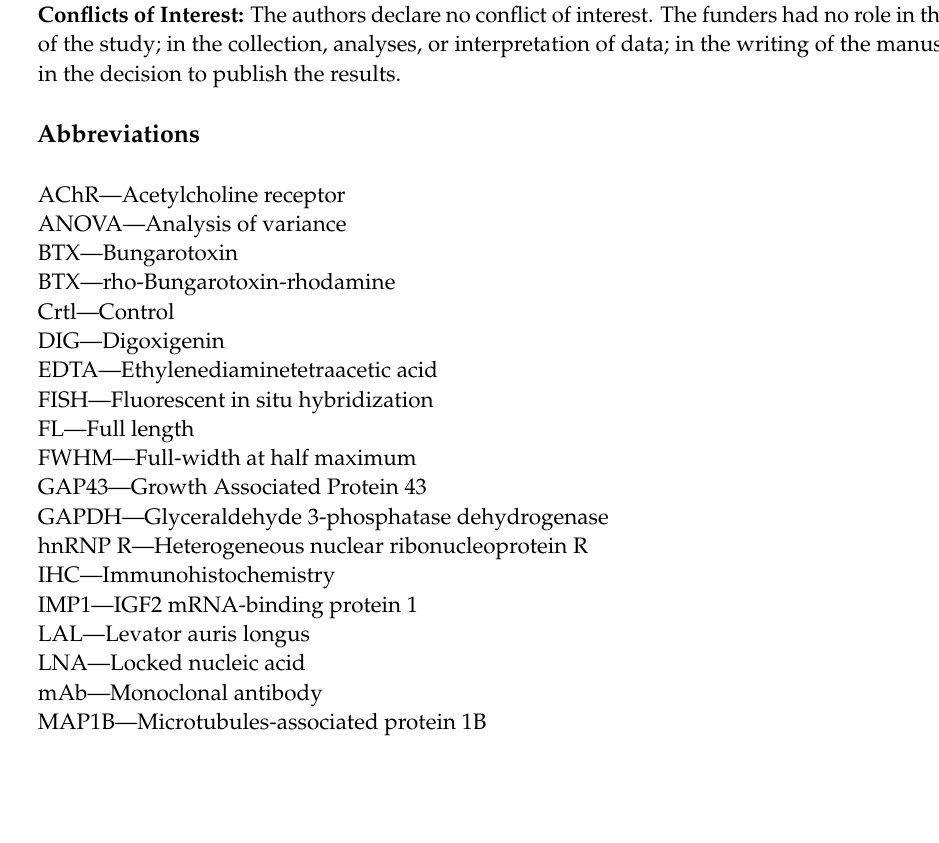
antibody. Figure S2: Establishment of experimental conditions for the detection of β -actin mRNA in neuromuscular preparations of TVA muscles. Figure S3: SMN ∆ 7 mutant and control presynaptic motor terminals contain lysosomes and autophagosomes. Figure S4: SMN granular pattern in the axons of control and SMA mice of two different muscles (TVA and LAL) at P9. Figure S5: SMN protein levels in the OA muscle and the spinal cord of wild-type and transgenic SMN ∆ 7 mice. Figure S6: SMN size and